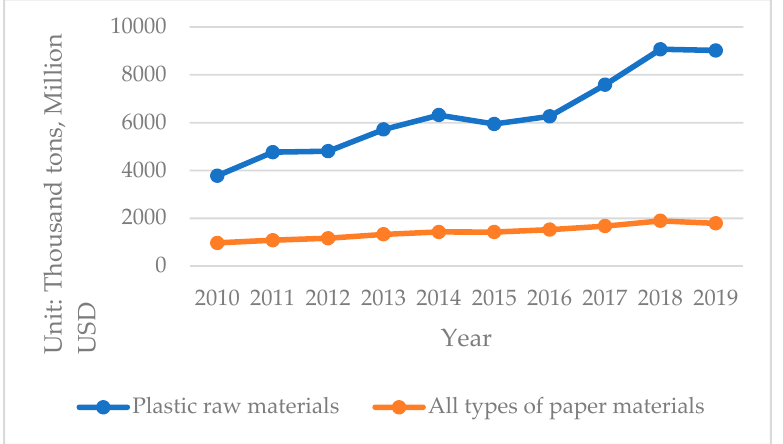
Figure 1. Import levels of some input materials for packaging production in Vietnam in 2010–2019 (Source: thongke.idea.gov.vn [7]).